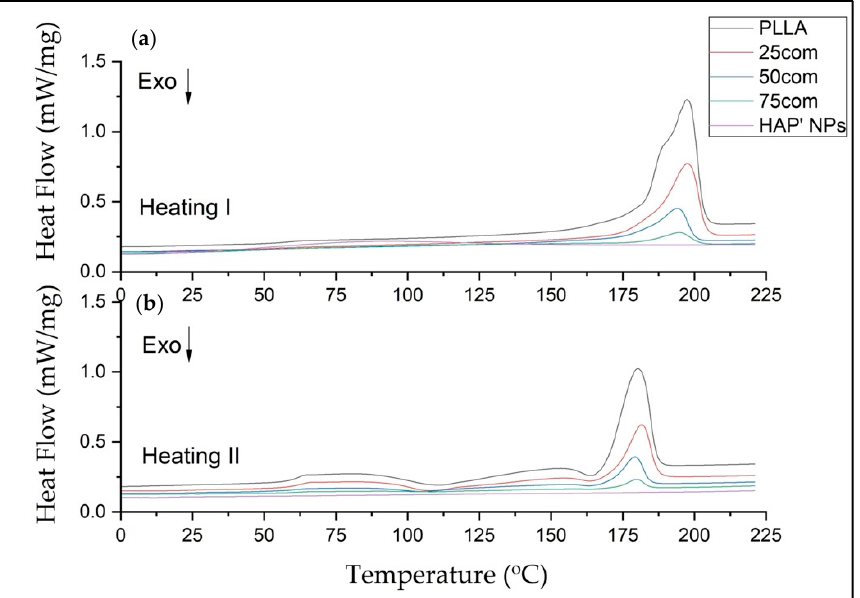
Figure 7. DSC thermograms of composites 25com, 50com, and 75com, as well as HAP NPs and PLLA samples, after first and second heating (a and b, respectively).